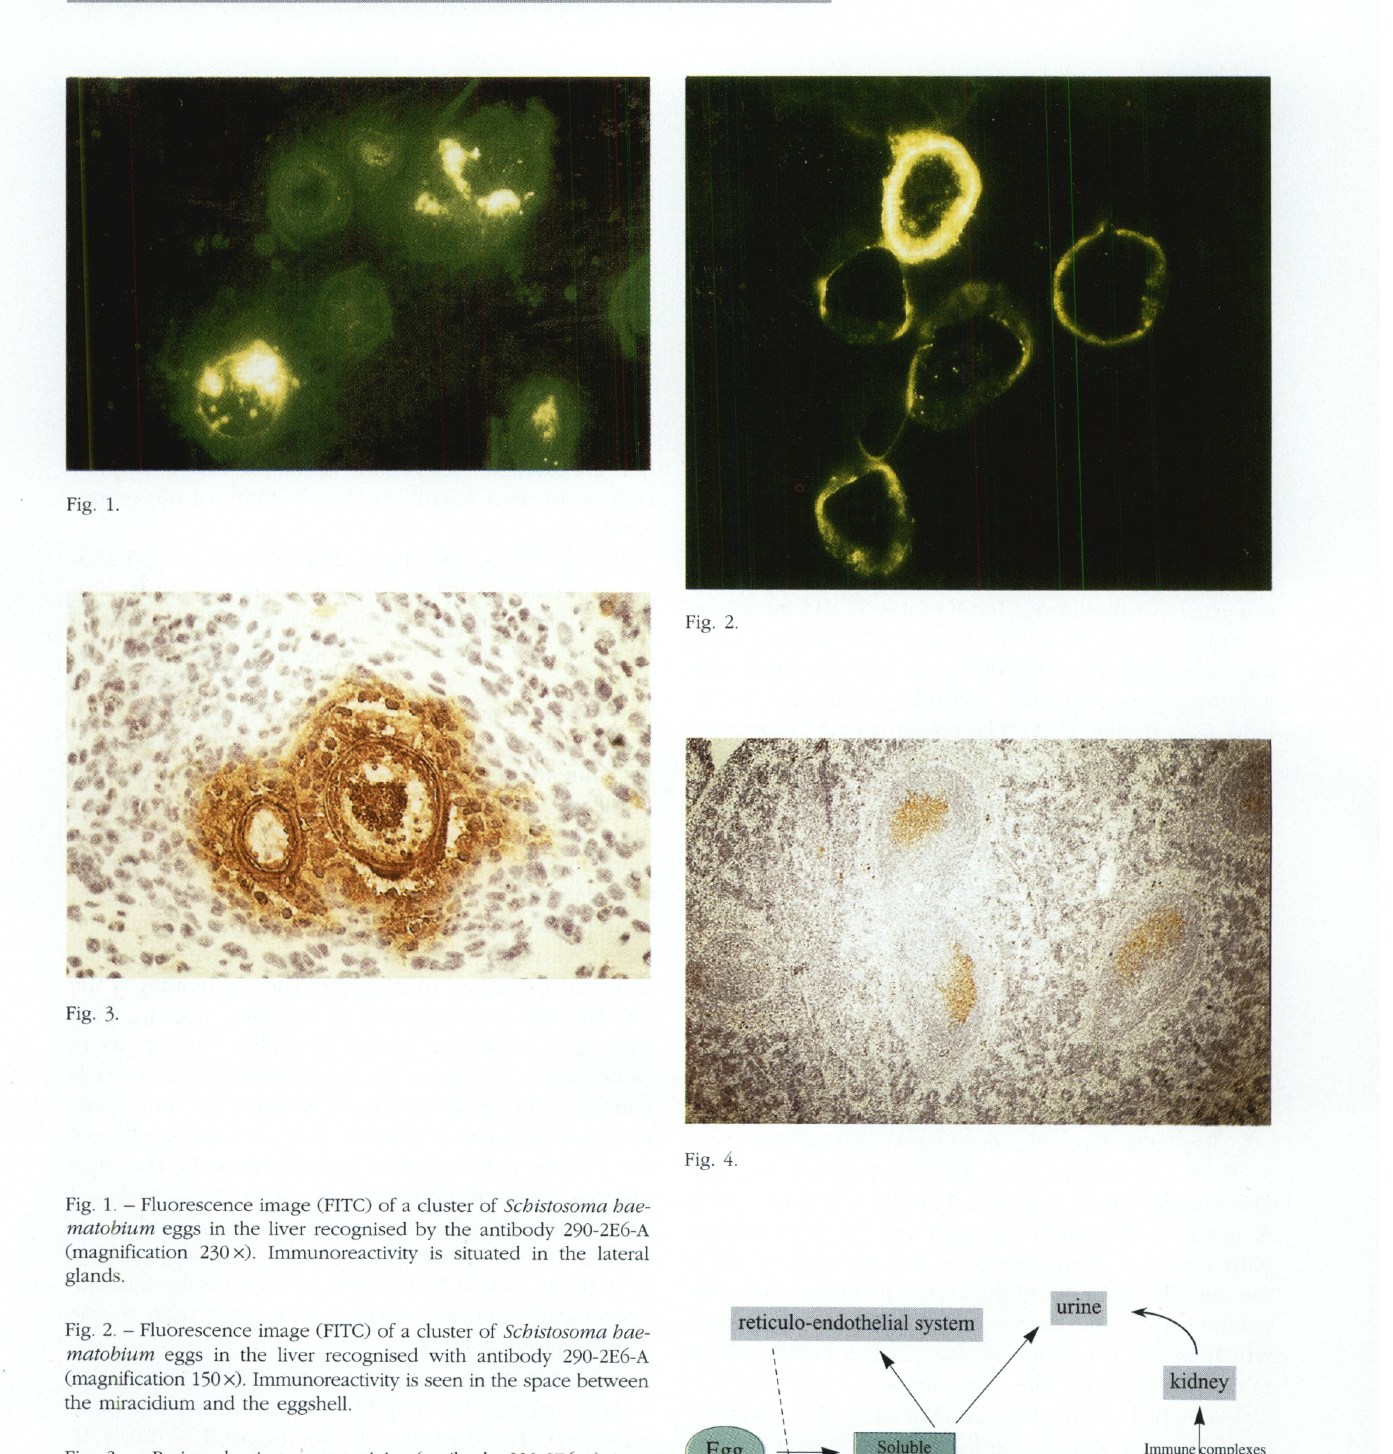
Fig. 1. - Fluorescence image (FITC) of a cluster of Schistosoma hae­ matobium eggs in the liver recognised by the antibody 290-2E6-A (magnification 230x). Immunoreactivity is situated in the lateral glands. Fig. 2. - Fluorescence image (FITC) of a cluster of Schistosoma hae­ matobium eggs in the liver recognised with antibody 290-2E6-A (magnification 150x). Immunoreactivity is seen in the space between the miracidium and the eggshell. Fig. 3. - Peri-ovular immunoreactivity (antibody 290-2E6-A) in a submucosal granuloma of the ileum (magnification 290 x, immuno- peroxidase staining). Fig. 4. - Immunoreactive germinal centres of lymphoid follicles in the spleen (290-2E6-A) (magnification 15x, immunoperoxidase stai­ ning). Fig.5. - Hypothesis of the fate of Schistosoma haematobium soluble egg antigens in the host’s